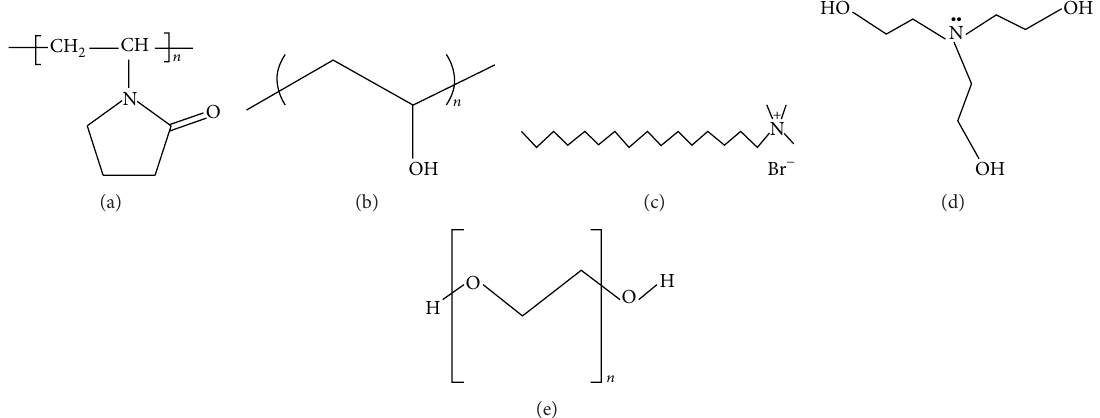
Figure 1: Chemical structure of (a) PVP, (b) PVA, (c) CTAB, (d) TEA, and (e) PEG.